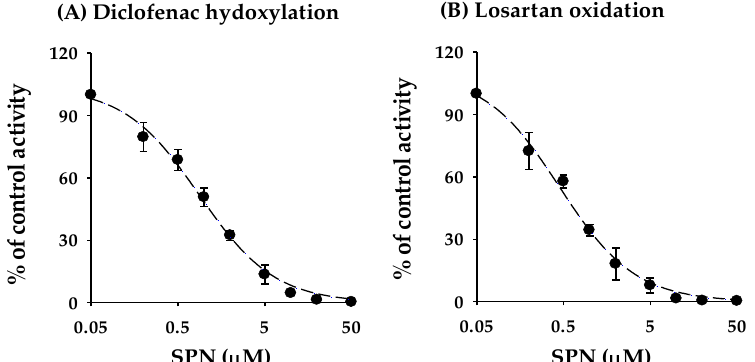
Figure 3. Inhibition curves of SPN on the CYP2C9-catalyzed diclofenac 4 ′ -hydroxylation ( A ) and losartan oxidation ( B ) activities in human liver microsomes. Data are the mean ± standard deviation of triplicate incubations. The dashed lines represent the best fit to the data with non-linear regression.